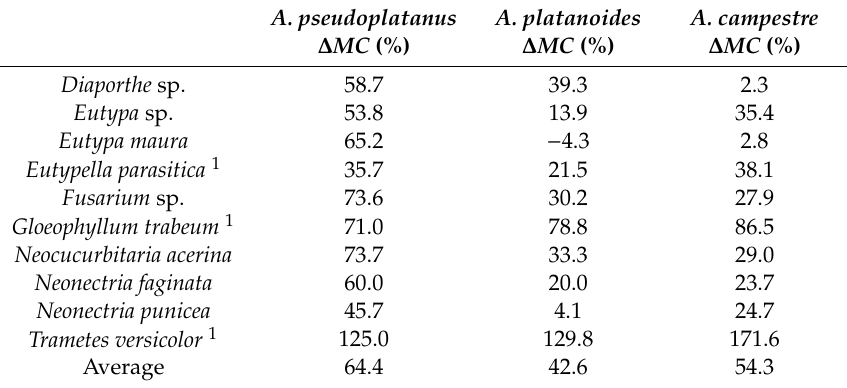
Table 2. Change in average moisture content ( ∆ MC ) of samples.